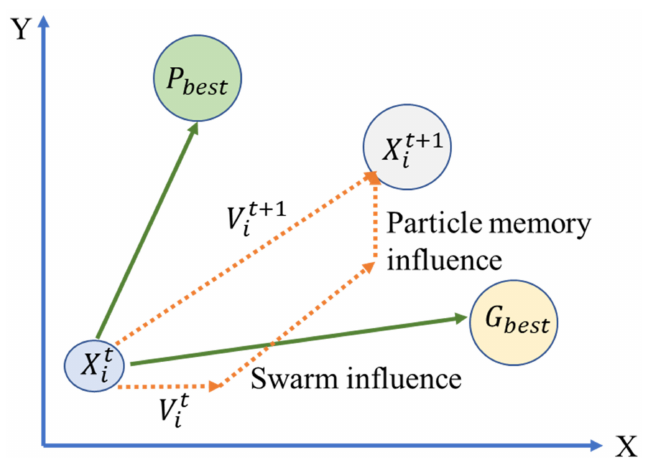
Figure 6. Representation of particle swarm optimization (PSO) model.